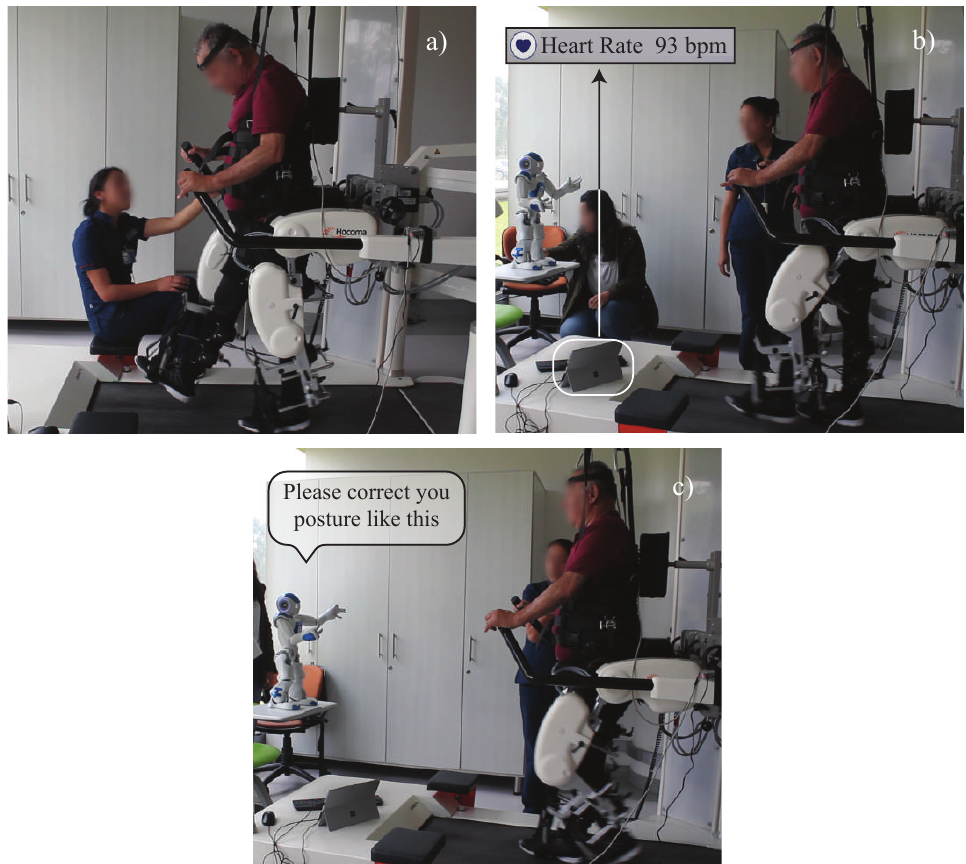
Figure 1. Video scenes of the robot assistance during Lokomat Rehabilitation. ( a ) Clinicians tasks performed during the conventional therapy, ( b ) On-line robot monitoring (e.g., heart rate acquisition), and ( c ) Robot supporting and providing feedback to the